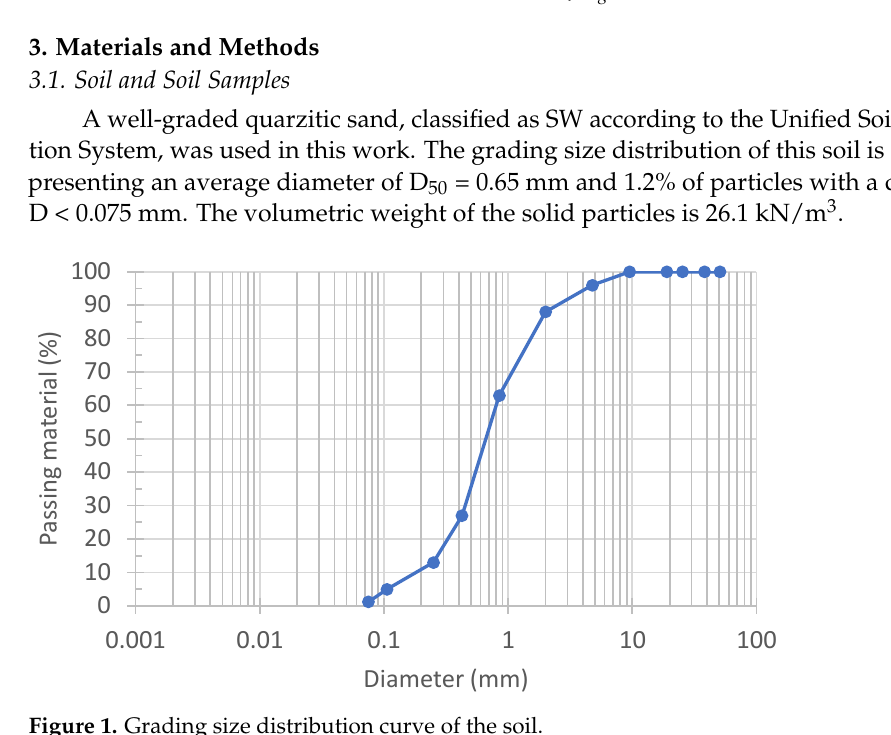
Figure 1. Grading size distribution curve of the soil.